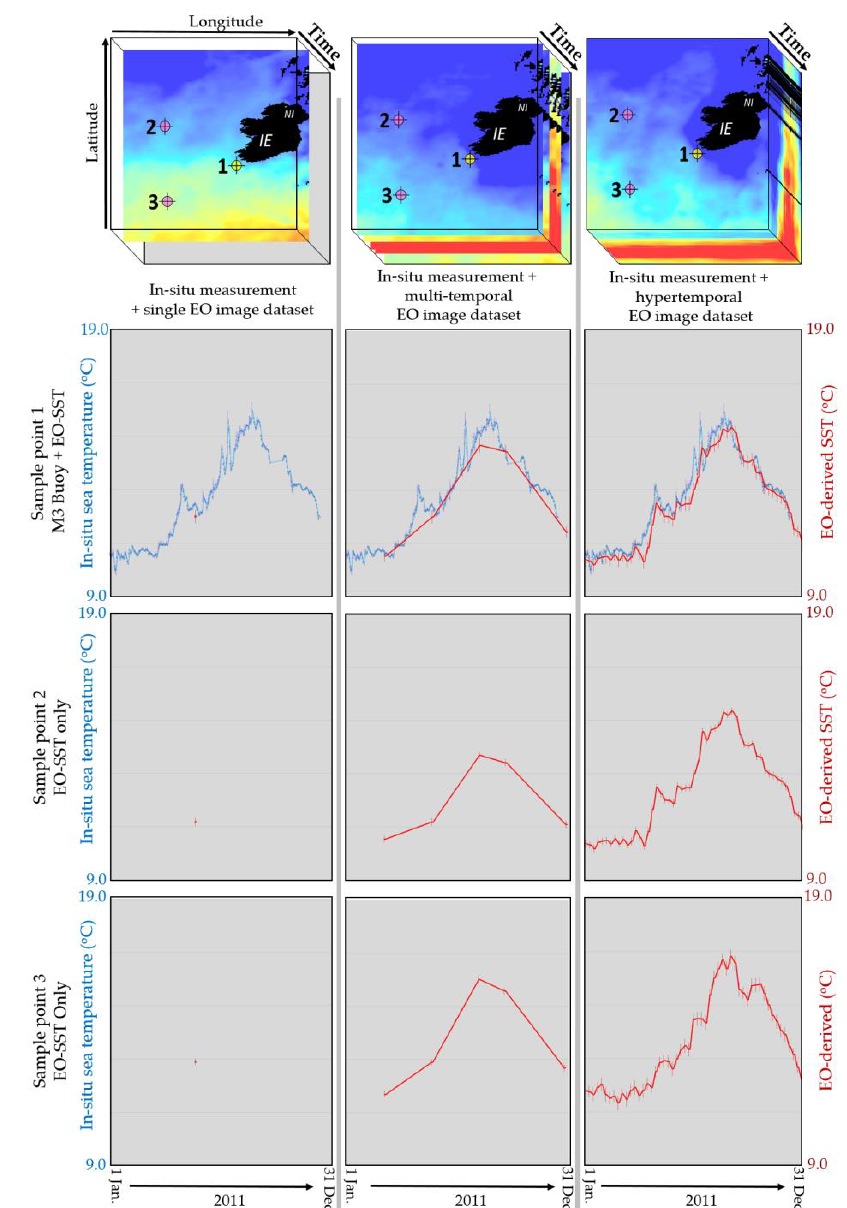
Figure 1. Hypertemporal data versus those of reduced spatial extent (in-situ data only) and temporal resolution. Shown are available in situ sea temperature data for 2011 versus Earth Observation (EO)-derived estimates of sea surface temperature (SST) for three sampling points near Ireland. Single-image, multi-temporal, and hypertemporal cases are arranged as three columns consisting of an image visual, and the data available for each sample point. Sampling point 1 can avail of both EO-derived (from the level-4 GHRSST product) and in-situ data (obtained from temperature sensors on board the M3 weather buoy). Sample points 2 and 3 can avail of EO-derived data only.